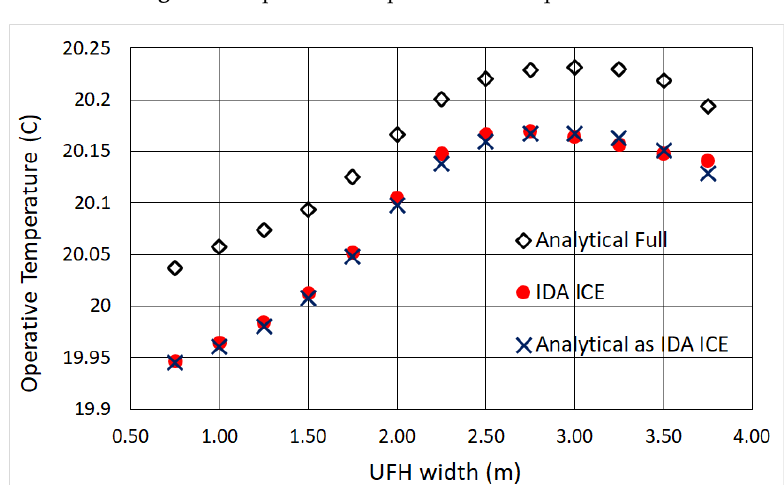
Figure 16. Operative temperature for a strip UFH.